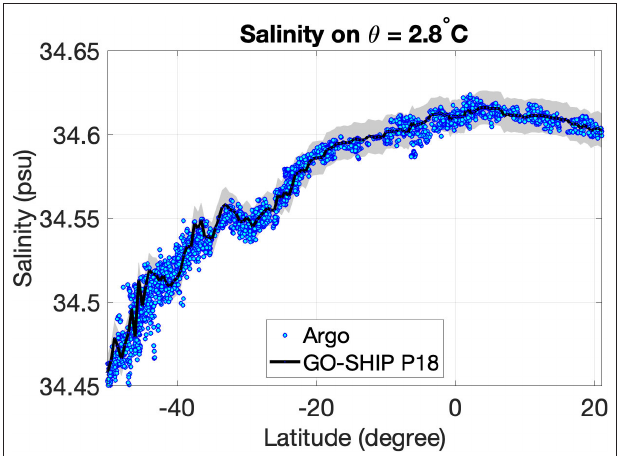
FIGURE 13 | Salinity on the potential temperature surface of 2.8 ◦ C along the P18 GO-SHIP occupation from 2016. P18 lies roughly along 110 ◦ W in the Pacific Ocean. Black line is salinity from the GO-SHIP CTD casts, and the gray shading shows a 0.01 PSS-78 envelope around the GO-SHIP measurements. Individual Argo salinity estimates from within 1 ◦ of the GO-SHIP stations are shown in